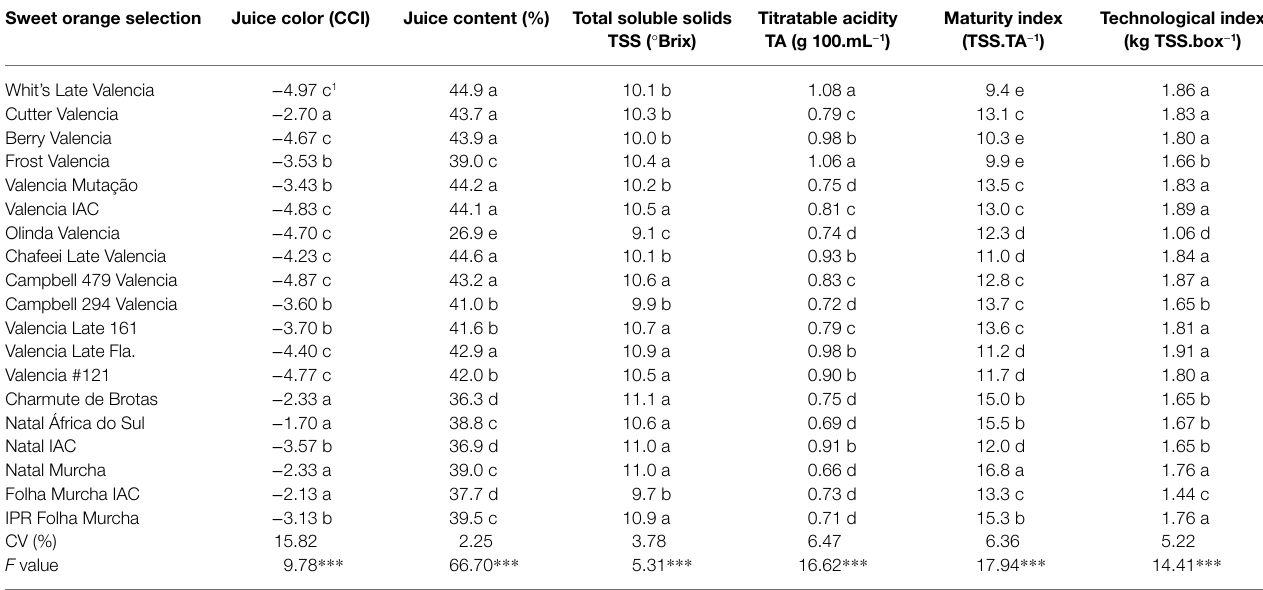
TABLE 5 | Three-season average juice quality of 19 late-season sweet oranges produced in Guairaçá, state of Paraná, Brazil, from 2019 to 2021. Sweet orange